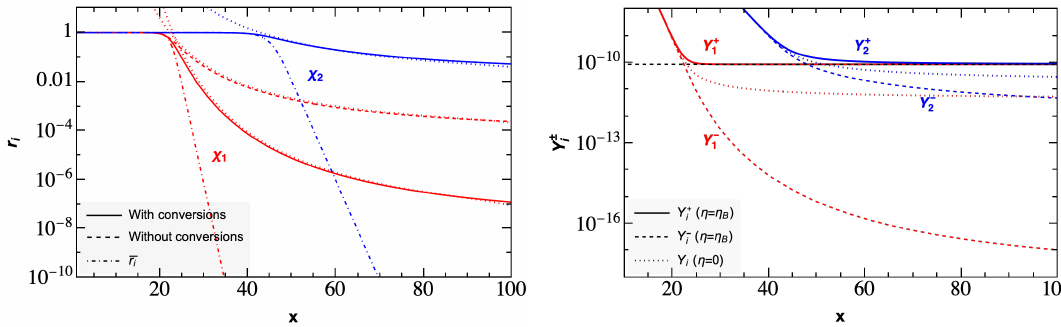
Figure 3 . Evolution of asymmetric ratios and yields for χ 1 (red) and χ 2 (blue) in the asymmetric case. We choose m = 20 GeV , m = 10 GeV , h σ = h σ = h σ = 2 pb and 1 2 ann , 1 v i ann , 2 v i conv , 12 v i η 1 , 2 = η B ∼ 0 . 88 × 10 − 10 . Left panel: numerical solution for asymmetric ratios r i in presence (solid) and absence (dashed) of conversions. The dot-dashed curves represent the equilibrium distributions ¯ r ( x ) . The dotted red and blue curves correspond to the analytic solution and coincides well with i the numerical solution. Right panel: the solid (dashed) curves correspond to Y + ( Y − ) , and the i i dotted curves correspond to the symmetric case i.e. η = 0 . The black dashed line corresponds to 1 , 2 the value of η . B